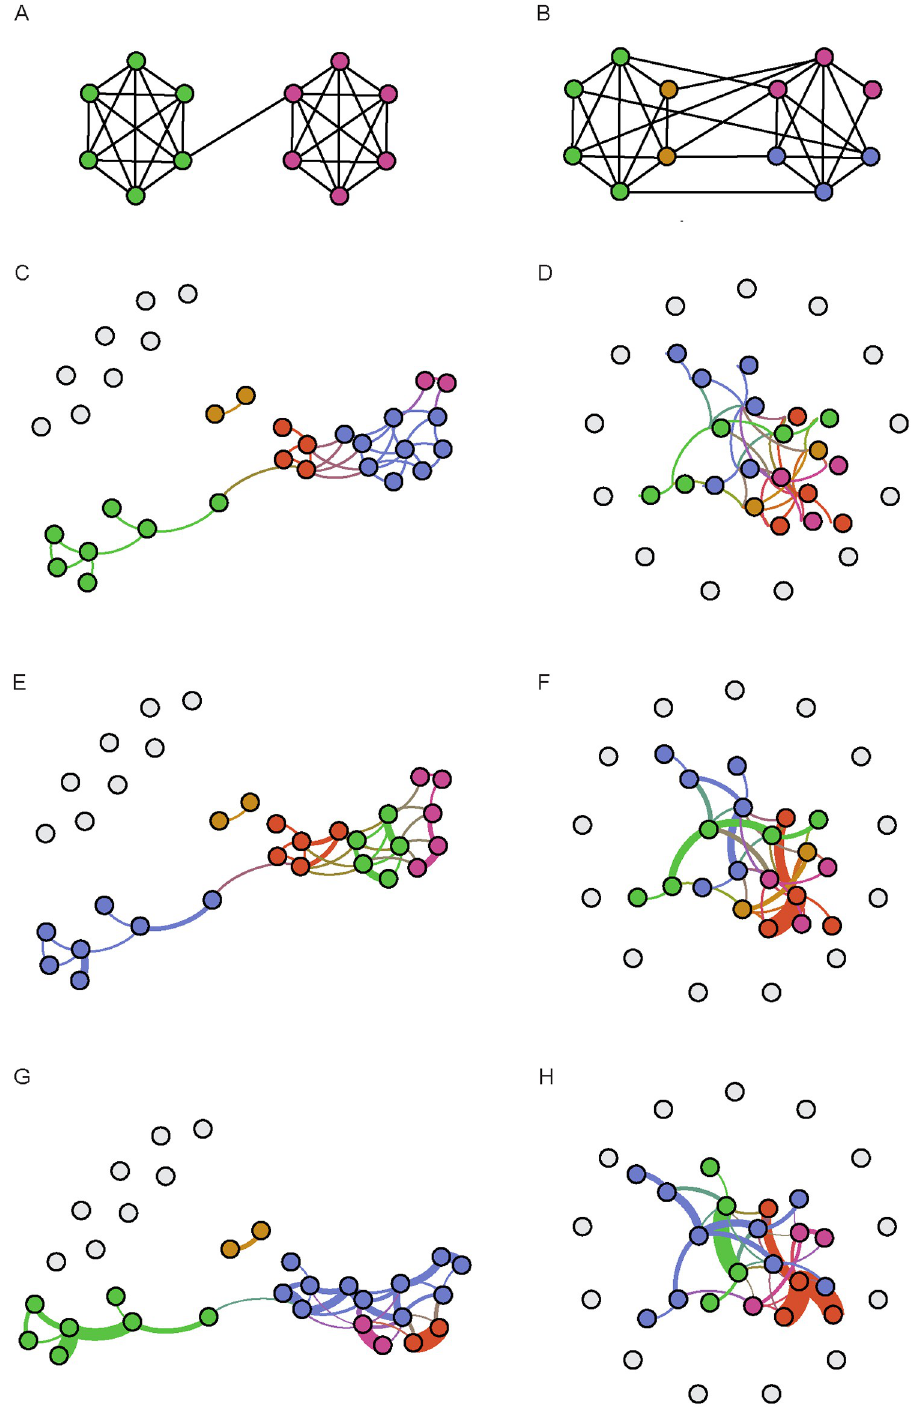
Fig 7. Correlation matrix. Image represents correlation of local level measures in created networks. A) is for CTRL networks and B) is for COC networks. Full names of measures that are abbreviated in the correlation matrix figure are: dc—Degree centrality, ce—Eigenvector centrality, cc—Closeness centrality, s—Strength distribution, bc—Betweenness centrality, C—Clustering coefficient and w—weight.